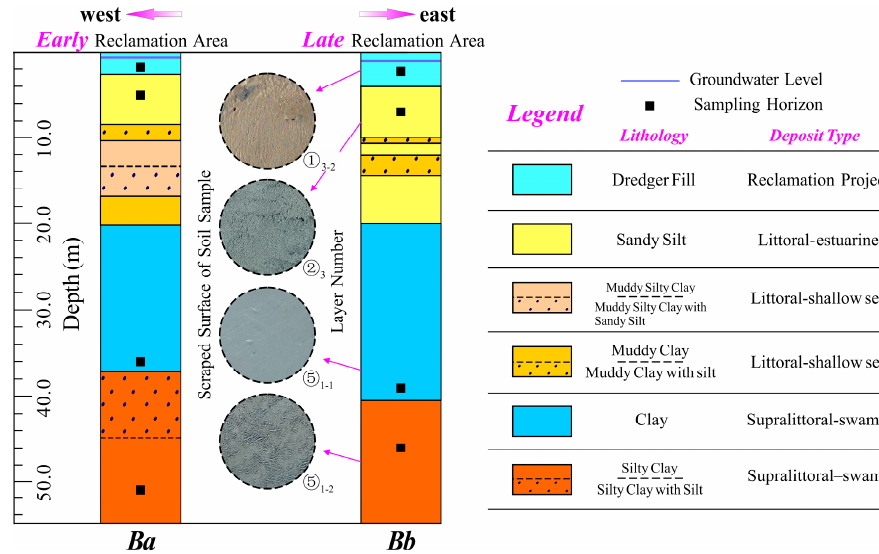
Figure 3. Stratigraphic structure of boreholes Ba and Bb, with the sampling horizons marked.